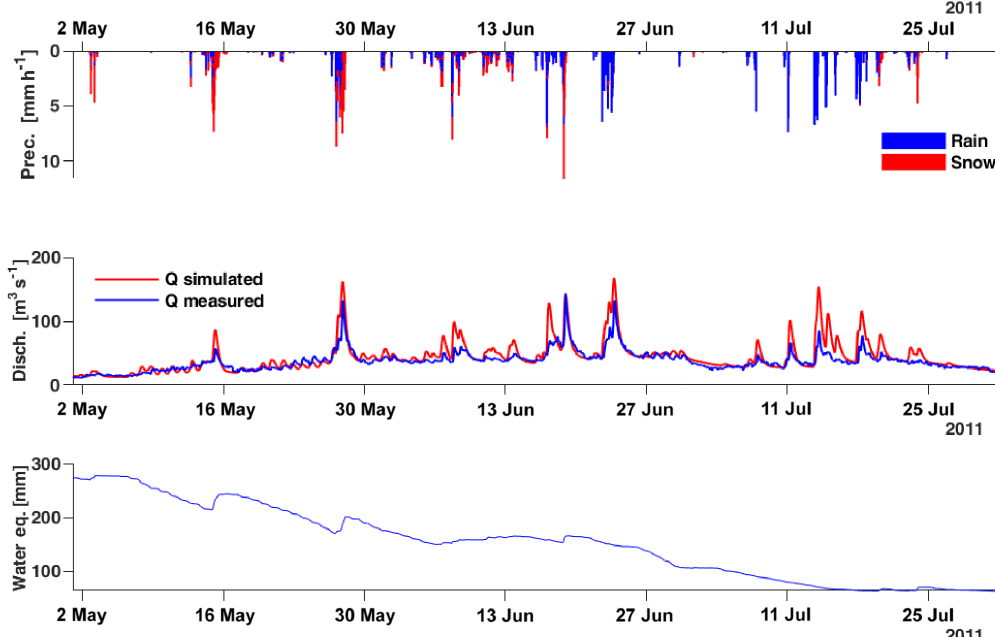
Figure 5. Comparison between simulated (W4-C10) and observed discharge at San Giorgio for the May–July 2011 period. The bottom plot displays the average w.e. over the basin.